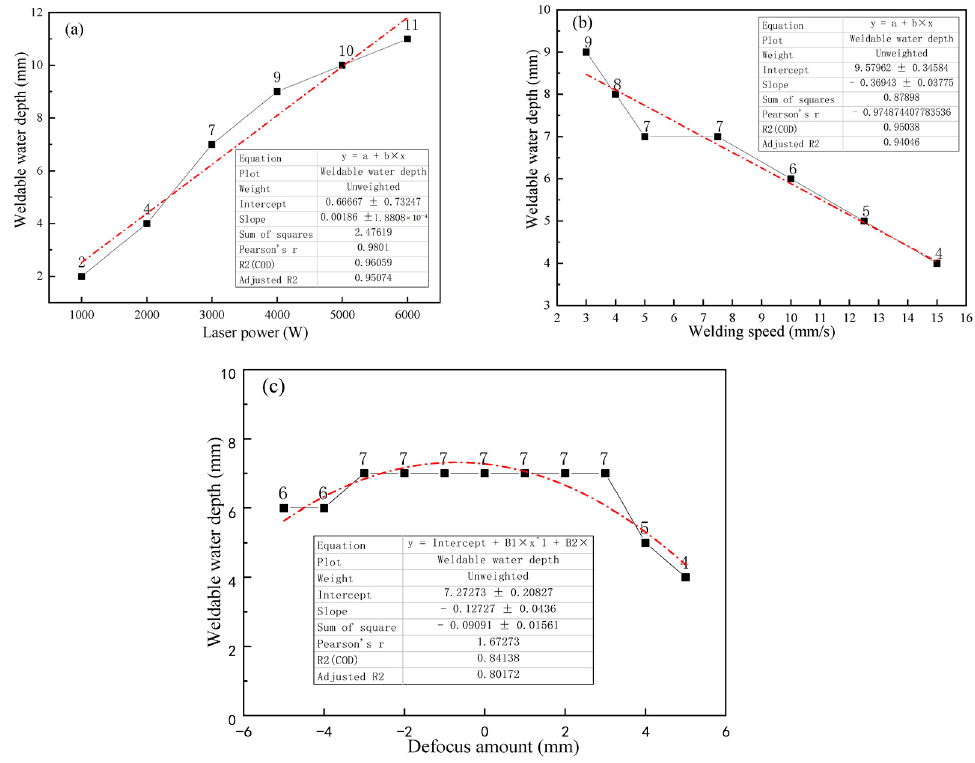
Figure 3. Effect of process parameters on welding depth: ( a ) laser power; ( b ) welding speed; ( c ) off-focus